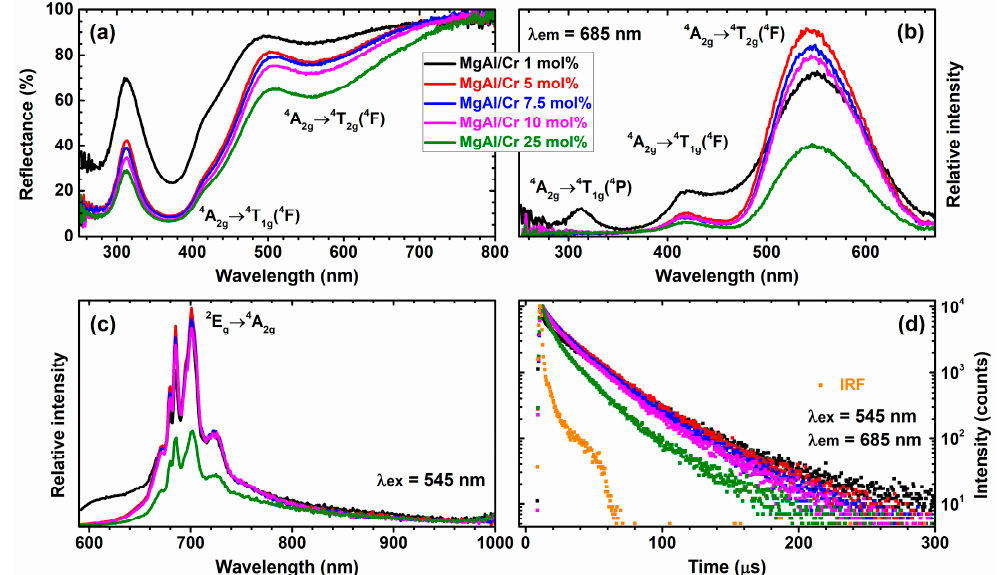
Figure 4. Reflection ( a ), excitation ( b ), emission ( c ) and photoluminescence (PL) emission decay curves ( d ) of Mg 3 Al 1 − x Cr x LDHs as a function of Cr 3+ concentration. Instrument response function (IRF) in section ( d ) stands for instrument response function.